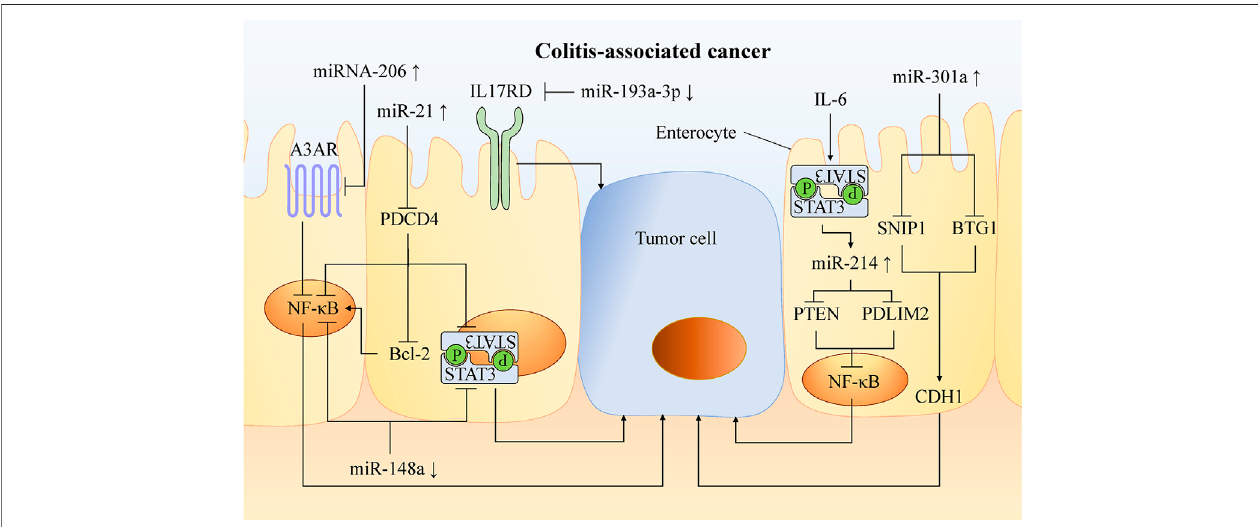
FIGURE3| MechanismofmiRNAinvolvedincarcinogenesisofUC.InUC,chronicactivationofcarcinogenicpathwayssuchasNF- κ BandSTAT3leadstoahigher riskofCAC.Avariety ofmiRNAscanpromoteor inhibittheoccurrenceofcancerbytargeting molecules inthese pathways. Increasingtheabundanceofanti-oncogenic miRNAsanddecreasingtheabundanceofoncogenicmiRNAscaninhibittumorformationandprogressioninexperimentalcolitis.Thisprovidesanewtherapeutictarget for the preventing and treatng CAC.